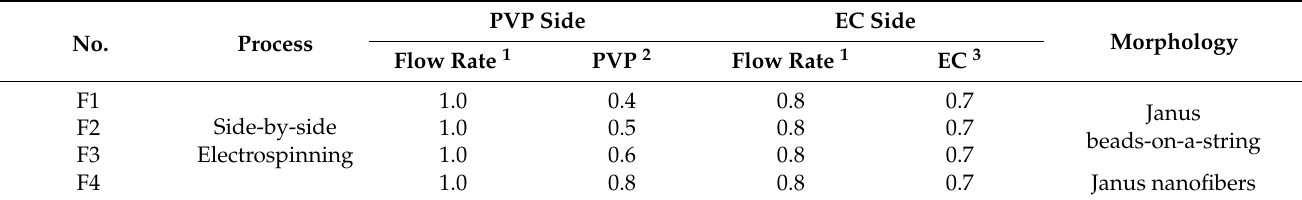
Table 1. Specific parameters for the side-by-side electrospun nanostructures. No.